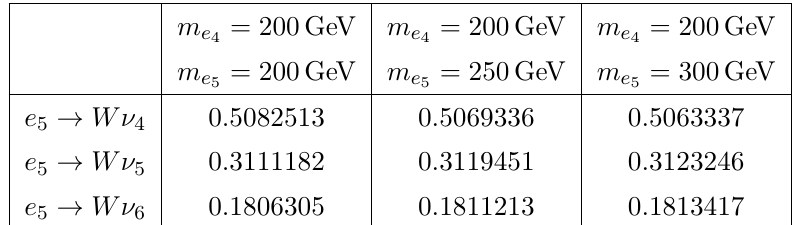
Table 9. Branching fractions of e 5 decaying into W and BSM neutrinos for three different e 5 masses and fixed m = 200 e 4